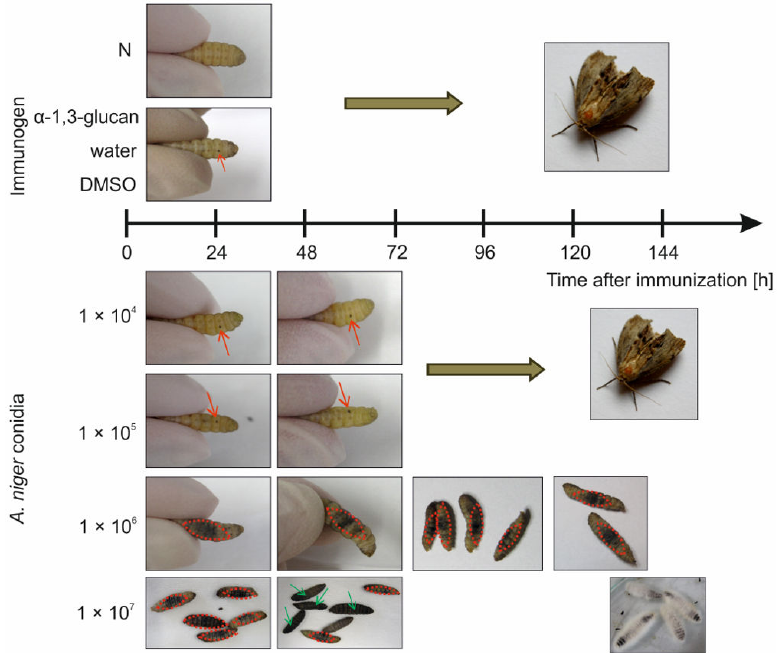
Figure 2. Changes in the appearance of G. mellonella larvae observed macroscopically after admin- istration of A. niger α -1,3-glucan or different doses of A. niger conidia. N—Non-immunized larvae. The red arrows and the red dotted line indicate melanized spots at the injection site and melaniza- tion on the abdominal surface of the larvae, respectively. The green arrows indicate completely melanized